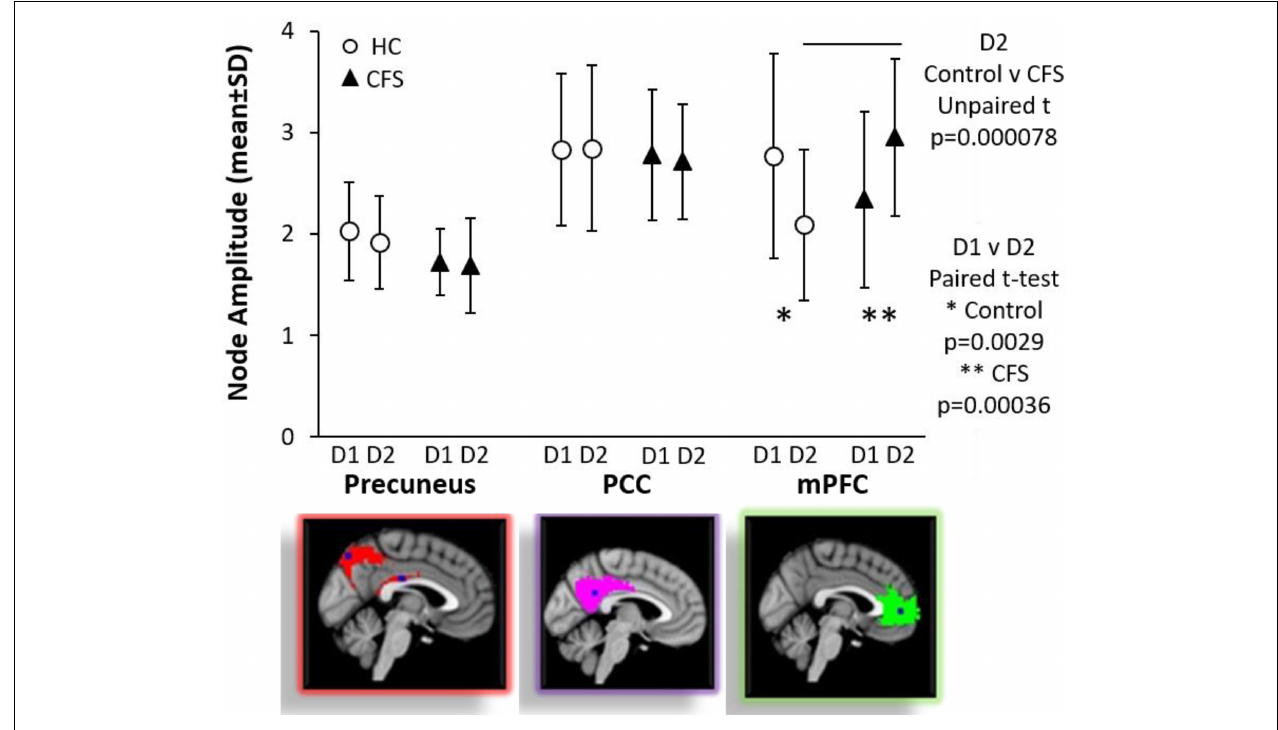
FIGURE 2 | Default mode network nodes. Node amplitude strengths were compared by ANOVA and Tukey Honest Significant Difference for differences between groups and by paired Student’s t -test for exercise effects between days within groups. DMN_PCC (red in top figure on right) and DMN_Prec (magenta in middle figure on right) were equivalent between control and CFS and between preexercise and postexercise scans. In contrast, exercise had significant effects on the anterior node in the DMN_mPFC (green in the bottom figure on the right). Node amplitude strengths were equivalent for CFS and control preexercise. Exercise caused a significant decrease in control ( ∗ p = 0.0029 by paired test), but a significant increase for CFS ( ∗∗ p = 0.00036 by paired test). As a result of the dynamic changes, CFS had significantly higher signal than control postexercise (line above error bars, p = 0.000078). Mean ±